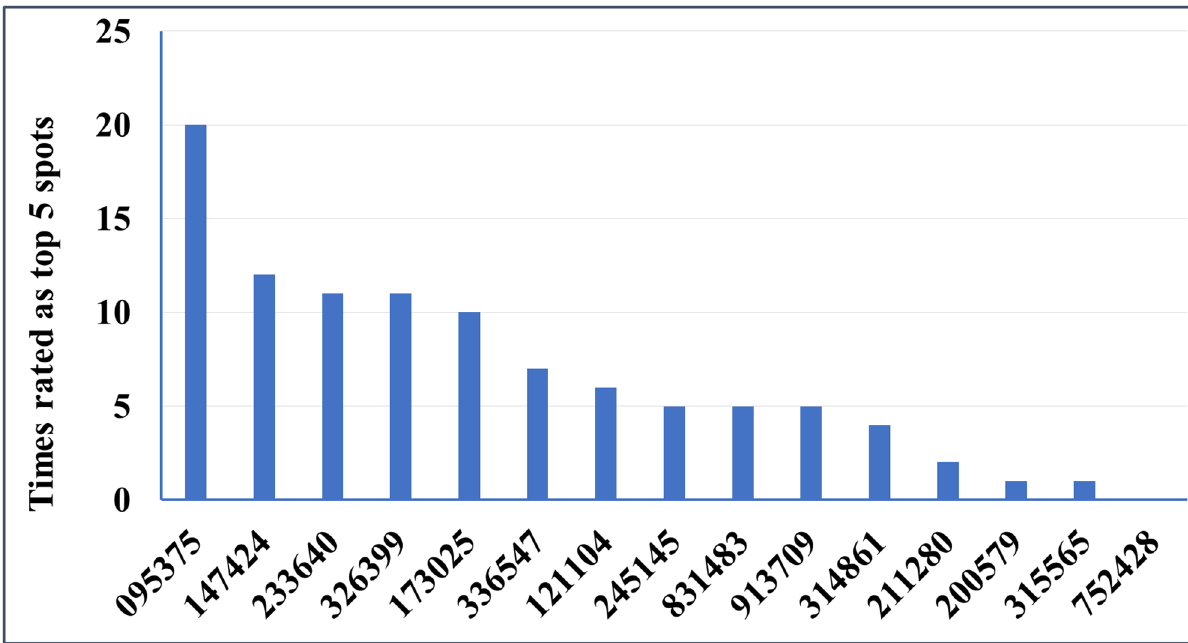
Fig 4. The frequency of appearance in top five spots by individual tested genes. Base on the ranking order by four different analytic methods and comprehensive ranking (see detail in Table 3), the values of Y axis indicatethe times for an individualgene being rankedin the top five spots from all four tissue types used. The distribution of the top-rated candidate genes from evaluationby various methodswere combinedto indicate their overall suitability as the most reliablereference genes for geneexpressionanalysisin apple root tissues.